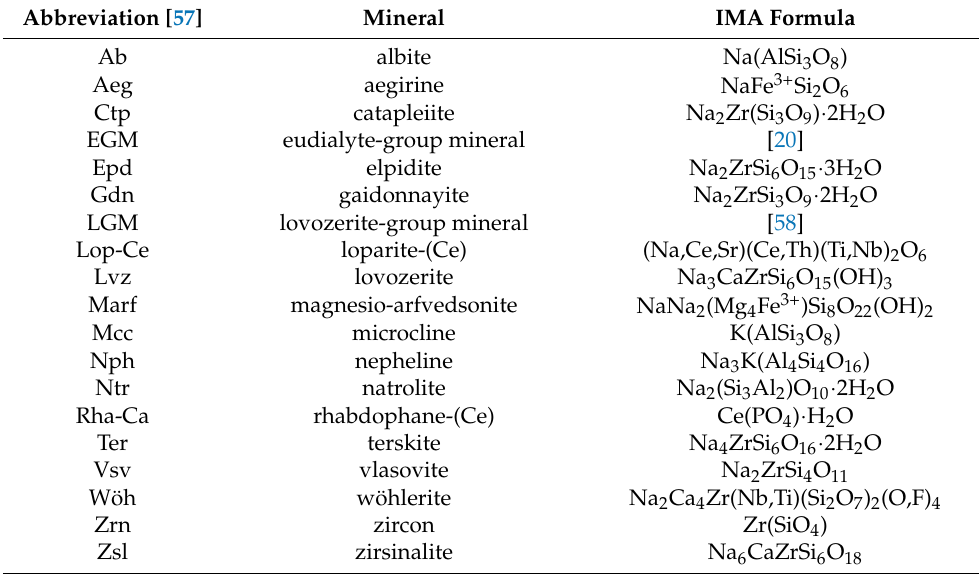
Mineral abbreviations (Table 1) are given in accordance with International Mineralogi- cal Association (IMA)-approved mineral symbols [57], with the exception of the eudialyte- and lovozerite-group minerals. Table 1. Abbreviations, names, and formulas of minerals mentioned in this article.